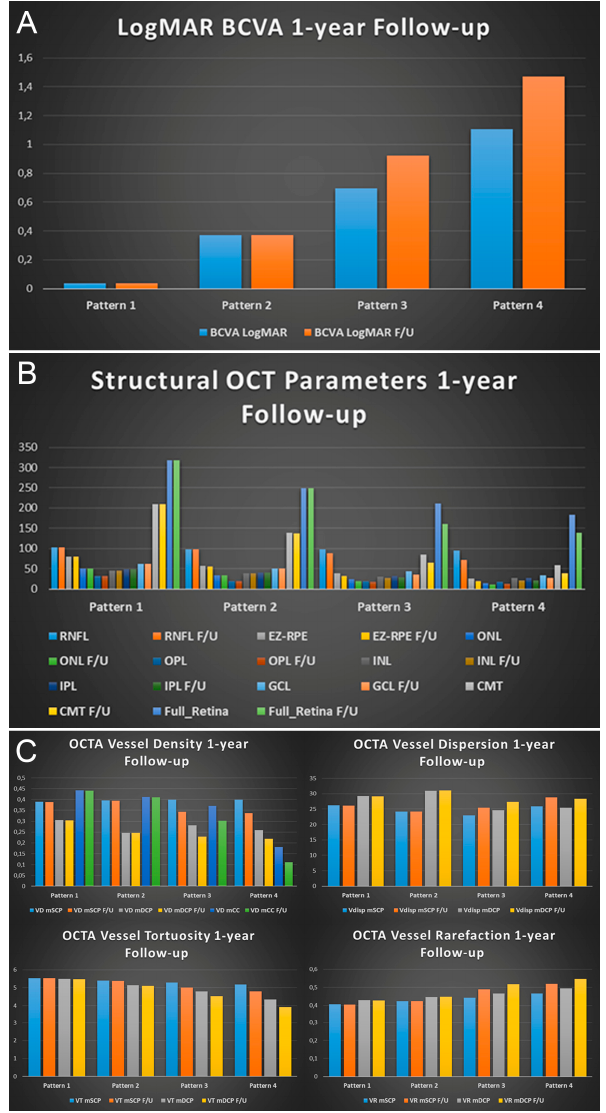
Figure 4. Bar graphs showing all the quantitative changes disclosed after 1-year of follow-up for each choroidal pattern. In details, the parameters for each choroidal pattern are shown as follows: ( A ) LogMAR BCVA; ( B ) thickness of each retinal layer, central macular thickness (CMT and retinal thickness; ( C ) quantitative OCTA parameters, namely vessel density, vessel dispersion, vessel tortuosity and vessel rarefaction. All the parameters and the p values are extensively reported in Table S3 of the Supplementary Materials.